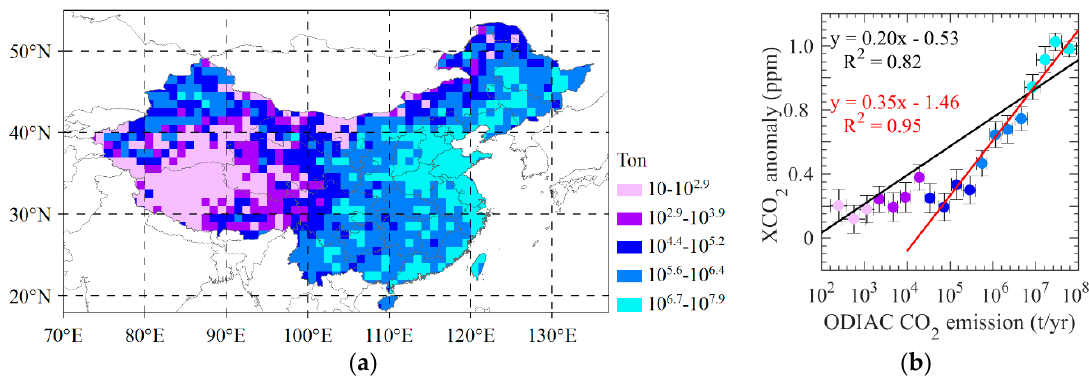
Figure 7. ( a ) Segment of ODIAC emissions, where the data are binned by every 0.3 t/yr of lgE using mean emission calculated from annual emission during 2010 – 2015; ( b ) correlation between mean ODIAC CO 2 emissions and mean dXCO 2 calculated from annual dXCO 2 during 2010 – 2015 for each segment, where red line is the regression line between dXCO 2 and ODIAC CO 2 emissions with emission lager than 10 4 t/yr.